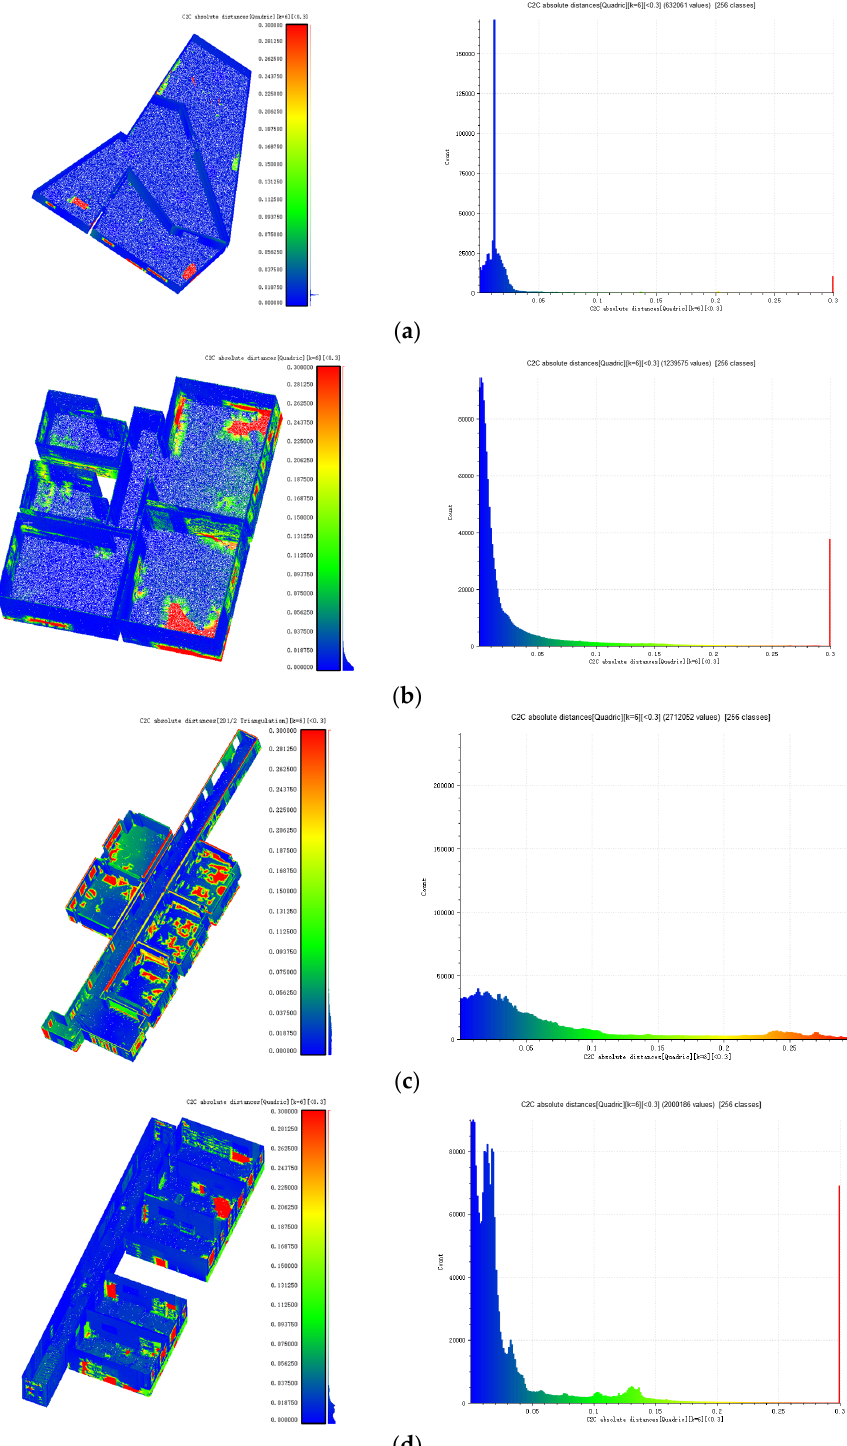
Figure 16. Visualization of unsigned distance deviations on the left and histogram of deviation statistics for the data on the right. ( a ) represents the accuracy evaluation results of Synth. ( b ) represents the accuracy evaluation results of Room. ( c ) represents the accuracy evaluation results of Office1. ( d ) represents the accuracy evaluation results of Office2.